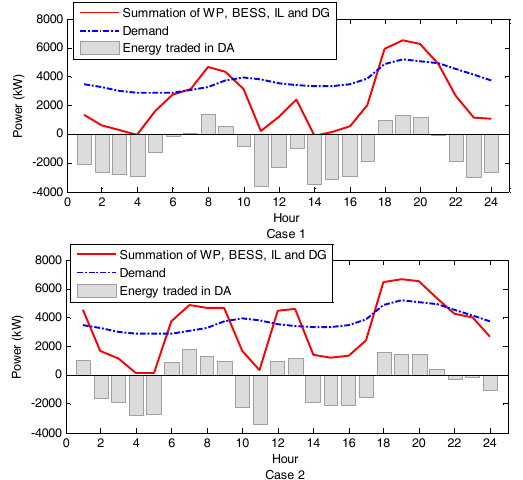
Figure 7. Power production and demand and energy traded in the DA market.